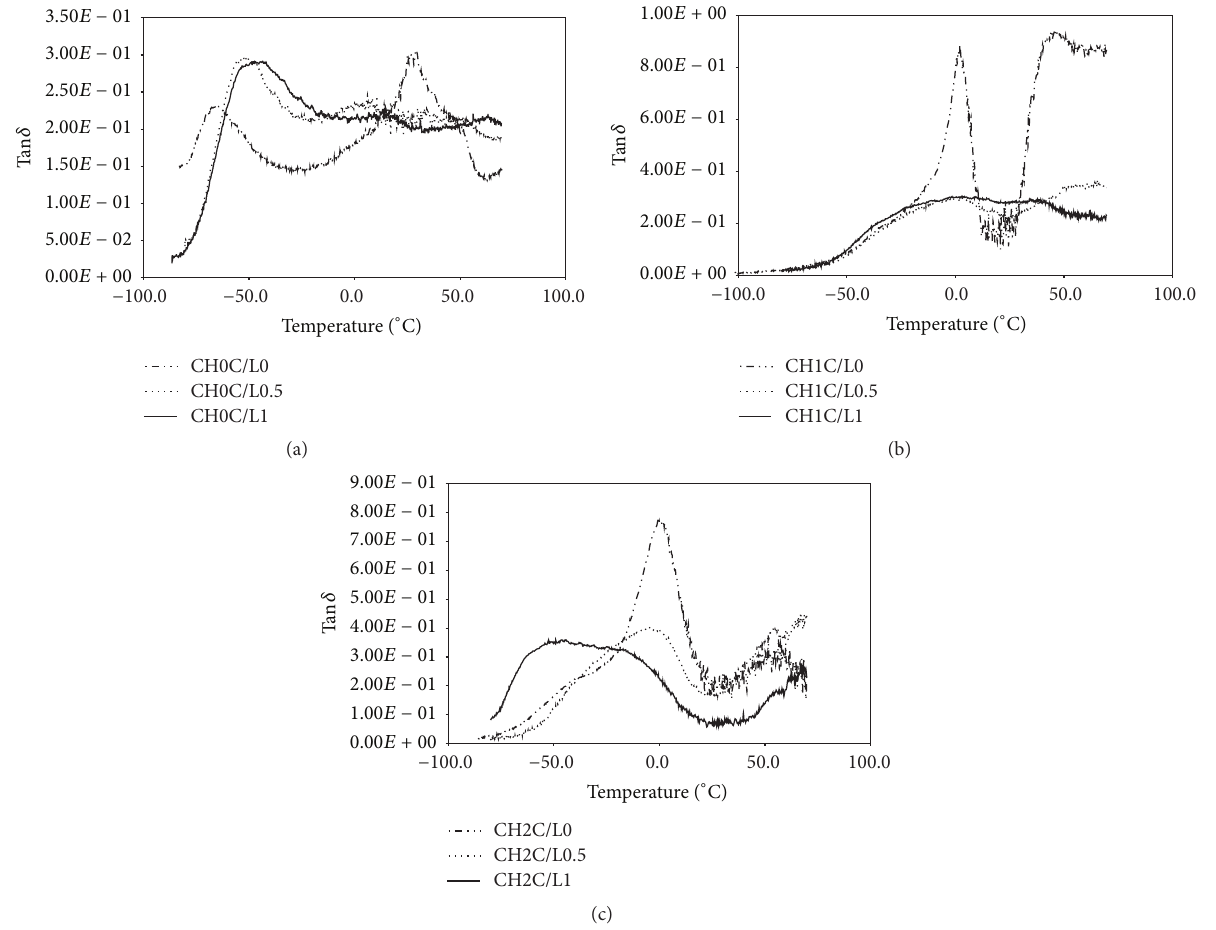
Figure 2: Tan 𝛿 of HPMC, CH, and C/L preparation films of (a) CH0C/L0, CH0C/L0.5, and CH0C/L1; (b) CH1C/L0, CH1C/L0.5, and CH1C/L1; and (c) CH2C/L0, CH2C/L0.5, and CH2C/L1